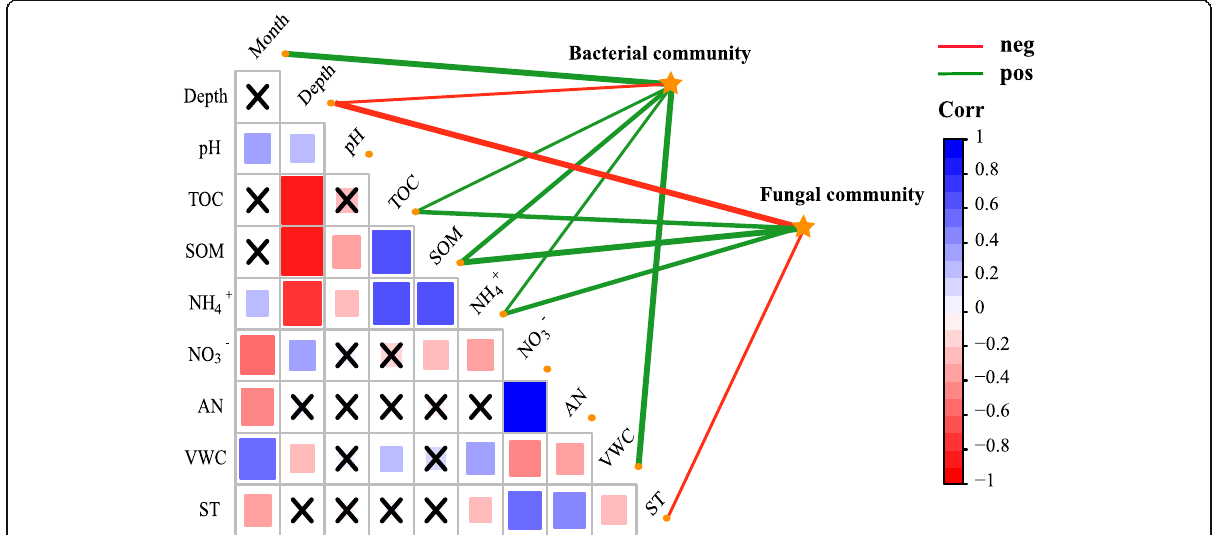
Fig. 3 Pearson correlation analysis between time of year (month), depth and soil properties, and bacterial and fungal community structures. TOC total soil organic carbon, SOM soil organic matter, AN available ammonium (the sum of NO 3 − and NH 4+ ), VWC volume water content of soil, ST soil temperature. Bacterial community was represented by abundance of OTU in bacteria. Fungal community was represented by abundance of OTU in Fungi. “ × ” indicates non-significance at p <